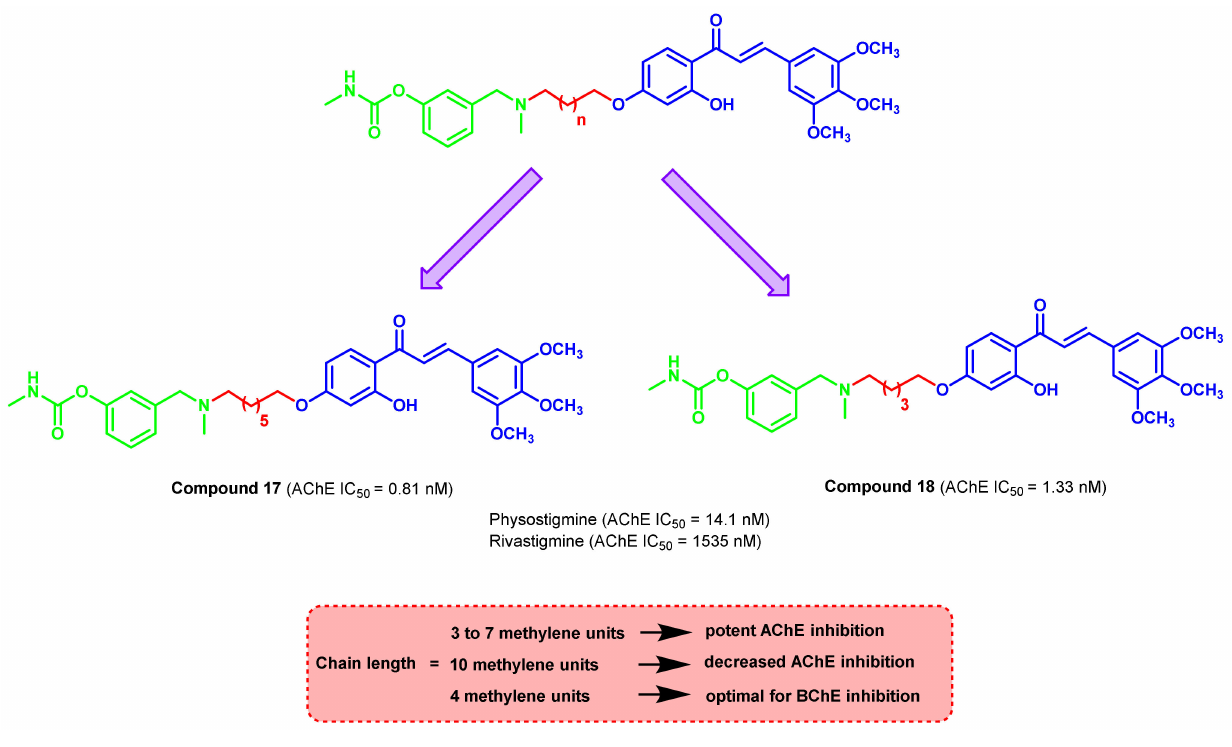
Figure 19. Chalcone–carbamate hybrid analogs.